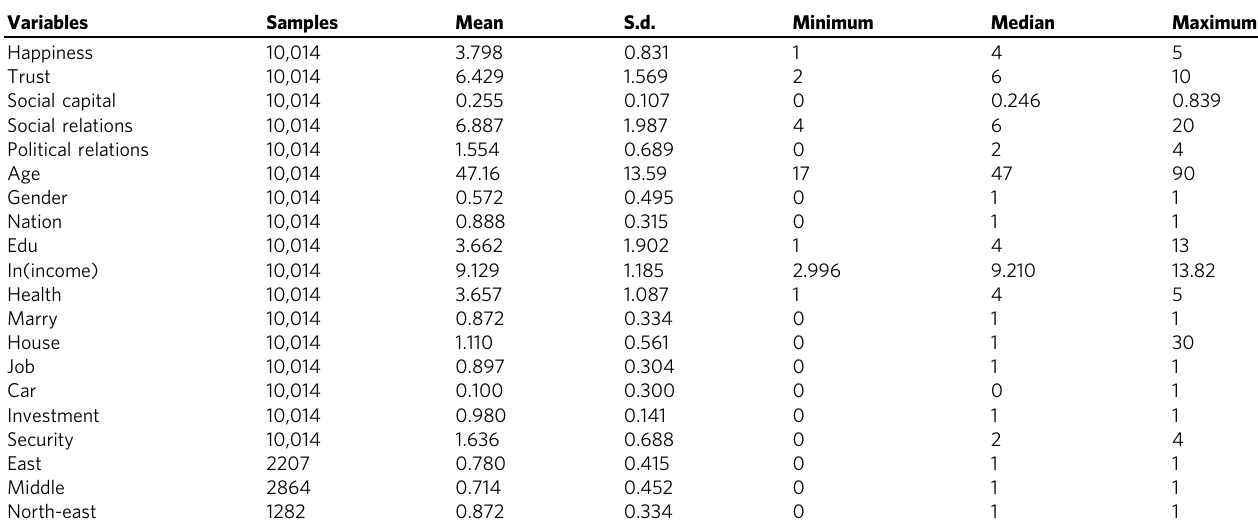
Table 2 Descriptive text statistics of variables ( n = 10,014).